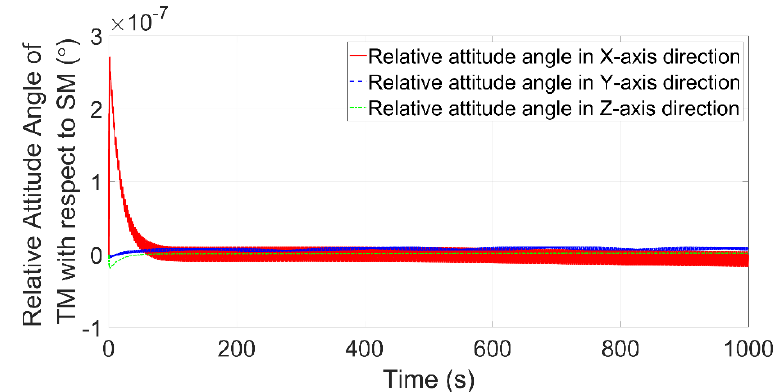
Figure 8. Attitude angle of the TM with respect to the SM.